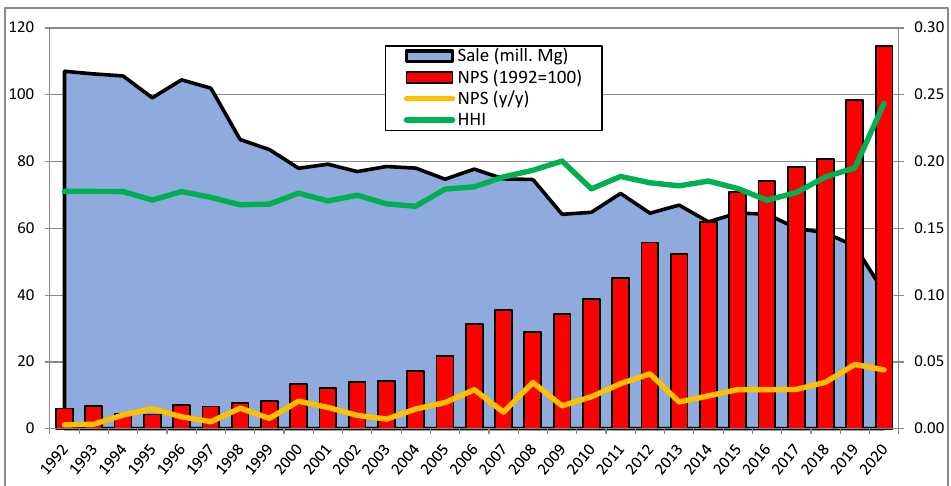
Figure 6. Coal sales, intensity of sales structure transformations ((NPS 1992 = 100%, NPS y/y), concentration (HHI) for coal mining enterprises in 1992–2020. Comments: coal sales—left axis. Other remarks as to Figure 5. Source: as in Figure